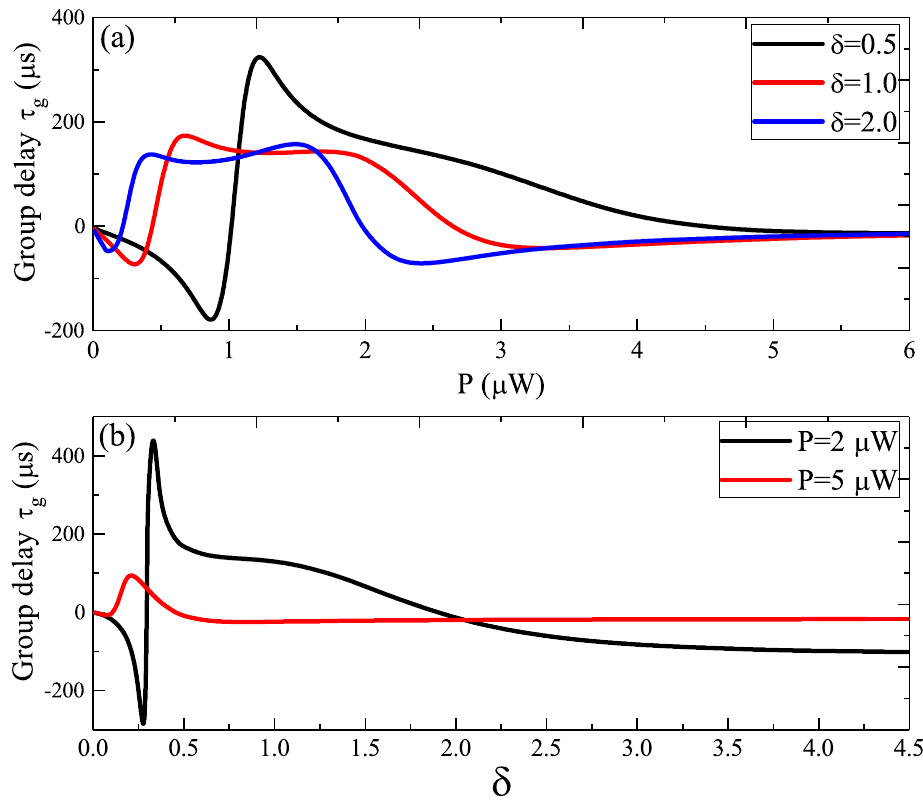
Figure 7. ( a ) The τ g as a function of P for three δ . ( b ) The group delay τ g as a function of δ for two P